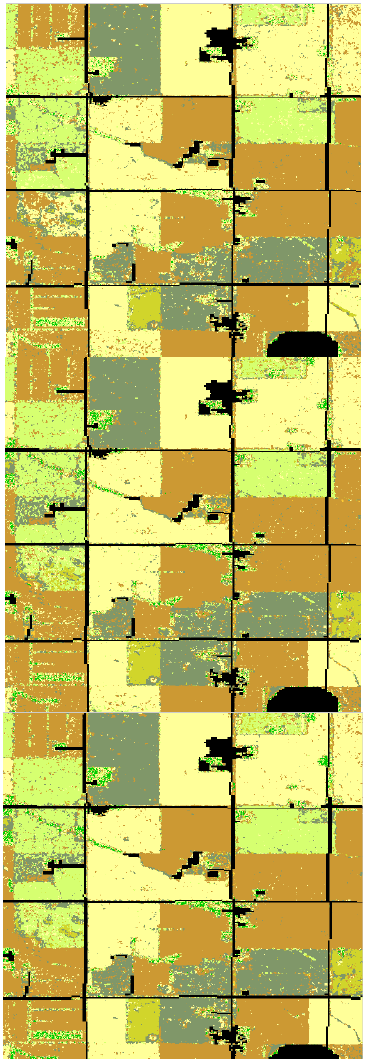
Figure 5. crop classification using linear kernel (up), polynomial kernel (middle) and RBF kernel